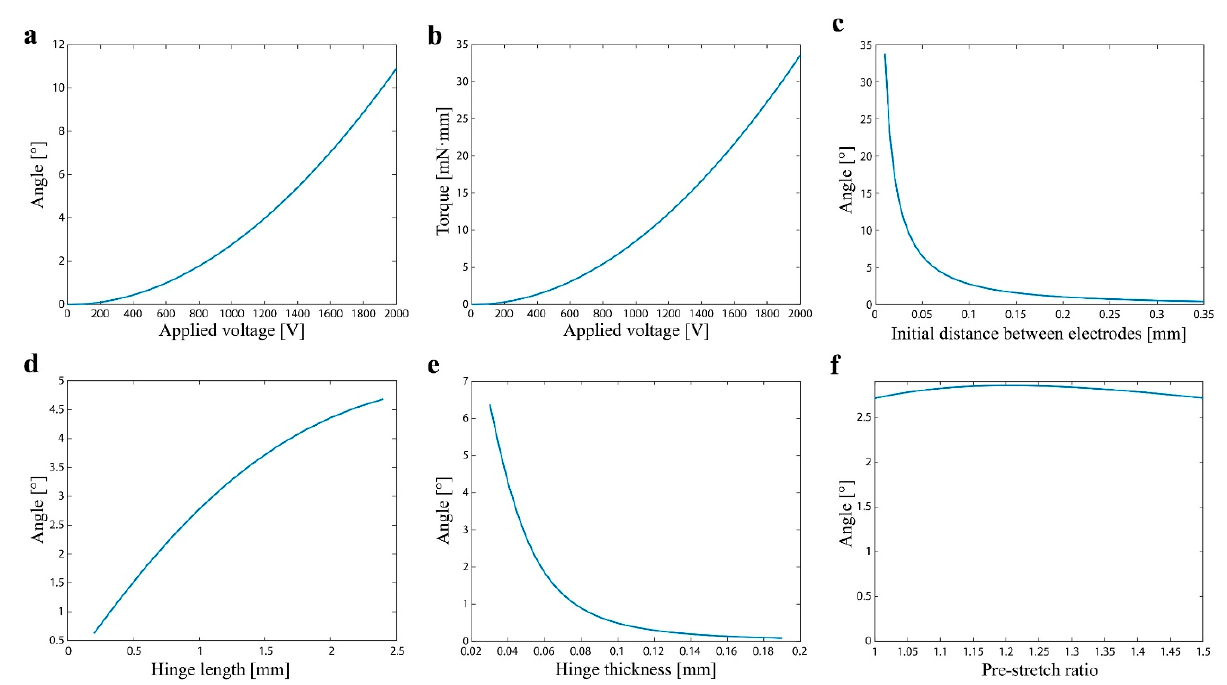
Figure 3. Typical output of the actuator model. ( a ) The tip angle and ( b ) torque as functions of the applied voltage. The tip angle as a function of the ( c ) initial distance between electrodes, ( d ) hinge length, ( e ) hinge thickness, and ( f ) pre-stretch